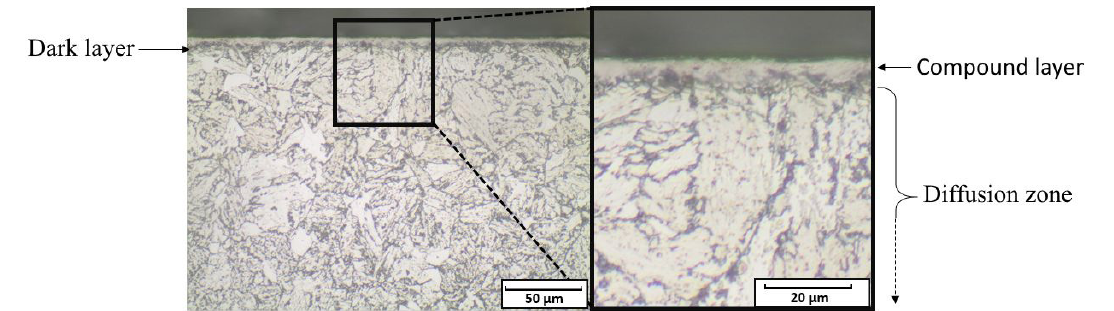
Fig. 2. Optical microstructure of cross-section of plasma nitrided sample at 450 °C for 6